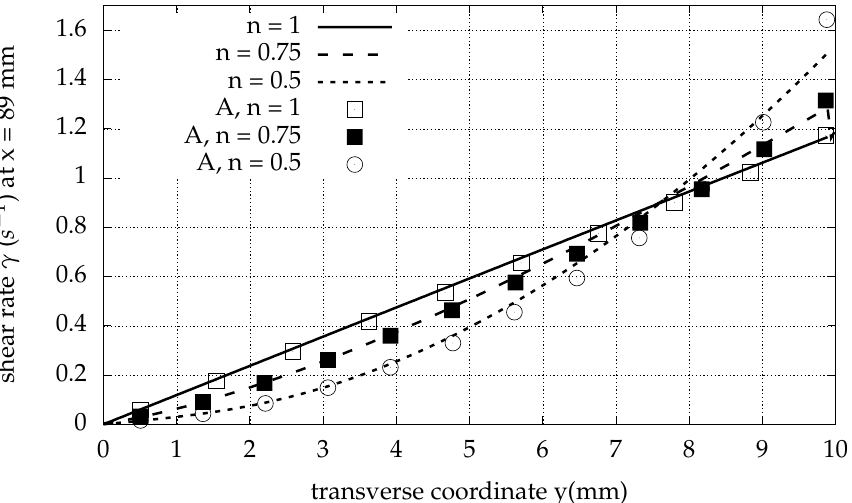
Figure 10. Shear rate profile at x = 89 mm for Newtonian and non-Newtonian fluids. The roller speed is c = 5 mm/s, the relative occlusion is RO = 0.6 and there is one roller. Comparison with existing results (A: Data from [12]) is